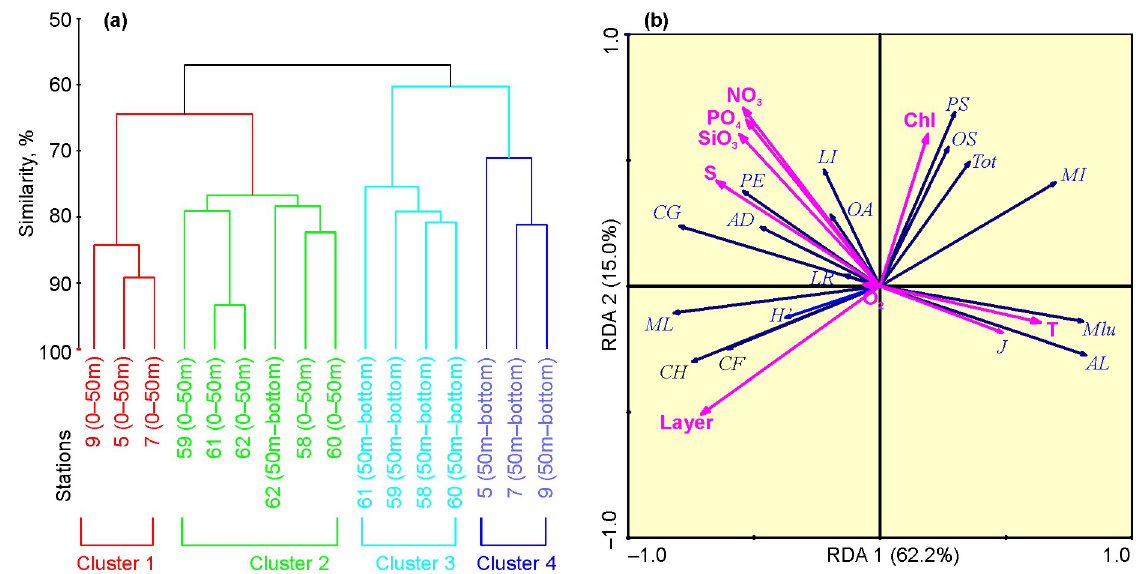
Figure 6. ( a ) Hierarchical dendrogram showing separation of sampling stations based on zooplankton abundance (Bray-Curtis similarity, group-average linkage) in the Fram Strait and in the Southern Barents Sea, winter 2021. ( b ) Results of redundancy analysis (RDA) based on lg(x+1)-transformed zooplankton abundance, and diversity indices in the Fram Strait and in the Southern Barents Sea,